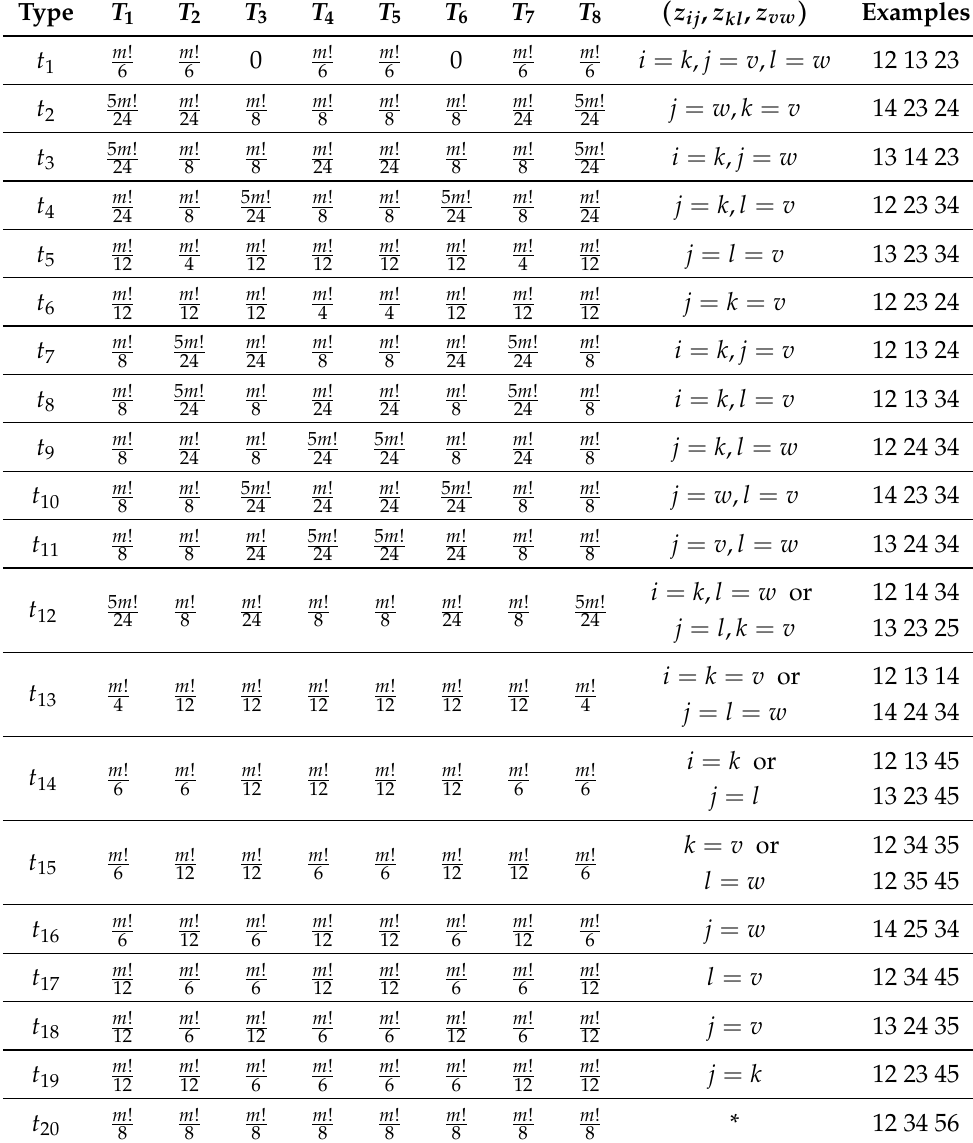
Table 2. Classifications of three-column subarrays of P m